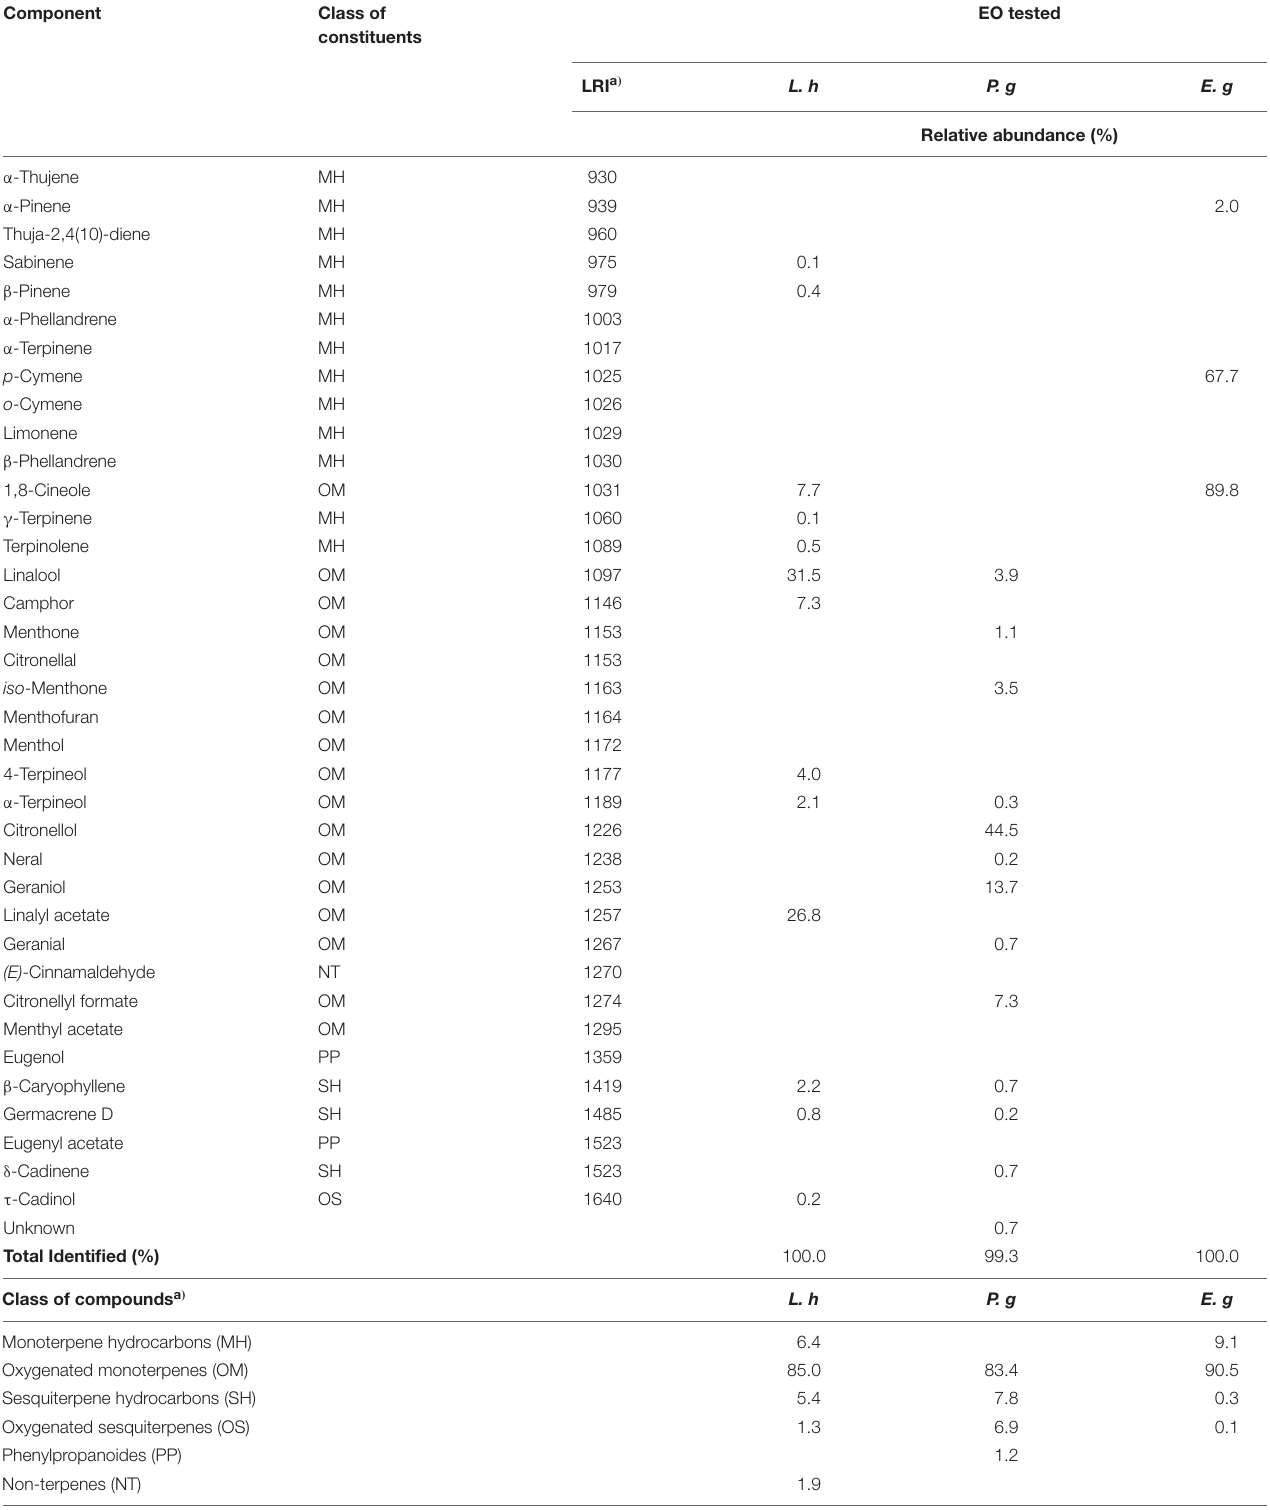
TABLE 1 | Chemical composition of tested